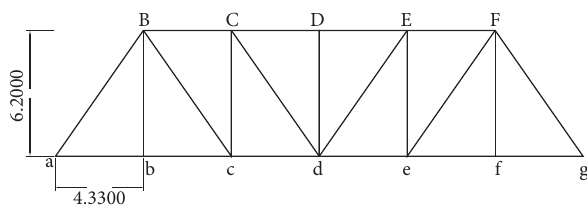
Figure 4: Structural scheme adopted [dimensions in